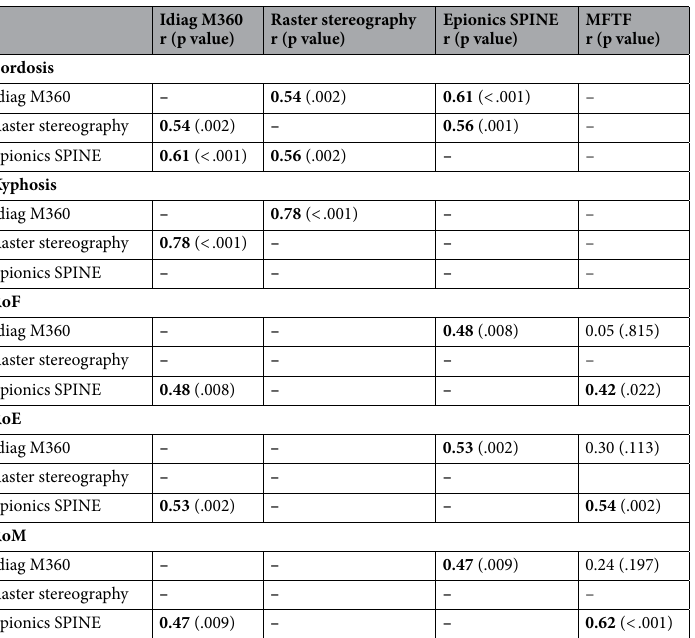
Table 3. Correlation (Pearson) between measurement data (mean values) obtained by the different devices and modified fingertip-to-floor distance; r = correlation coefficient; MFTF = fingertip to floor distance; all correlations that are statistically significant (p value < 0.05) are marked in